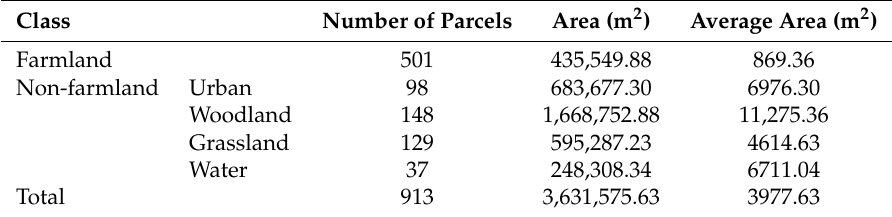
Table 2. Distribution of the reference parcels per